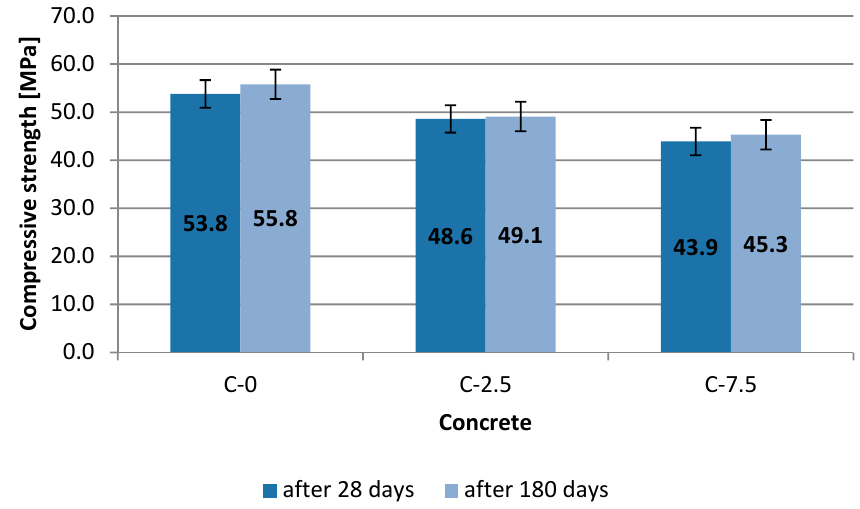
Figure 6. Compressive strength of concrete—10 cm cubes.